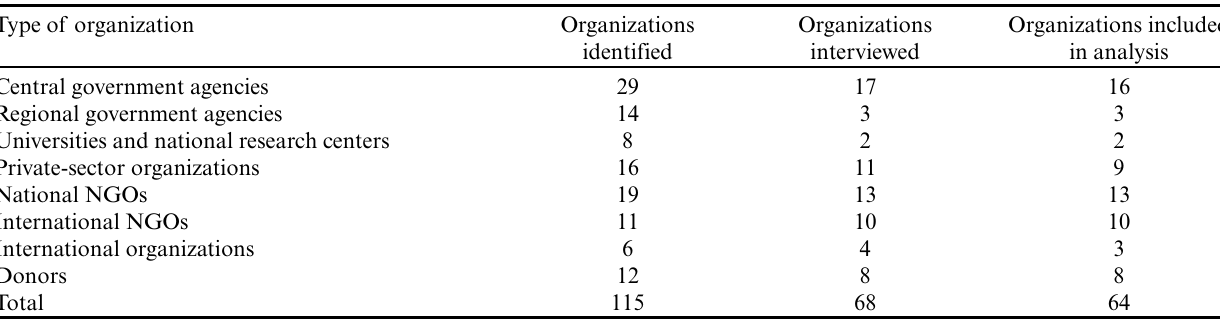
Table 1 . REDD+ policy actors in